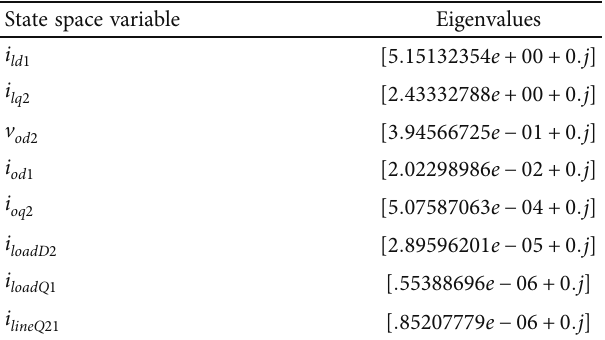
Figure 20: State variable PC1 and PC2 coe ffi cient. Table 5: Selected state space variables with high PC coe ffi